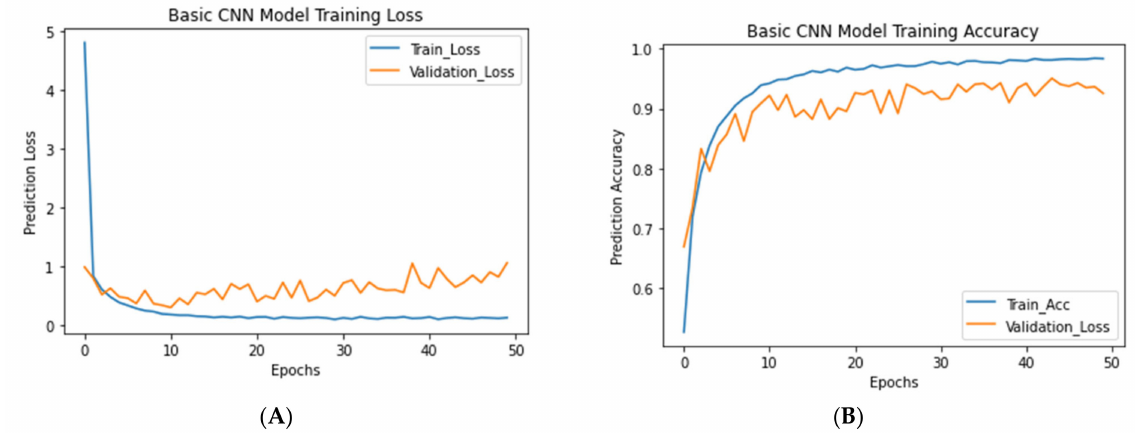
Figure 5. Basic CNN Model Testing. ( A ). Prediction losses as a function of epochs. ( B ). Prediction accuracy as a function of